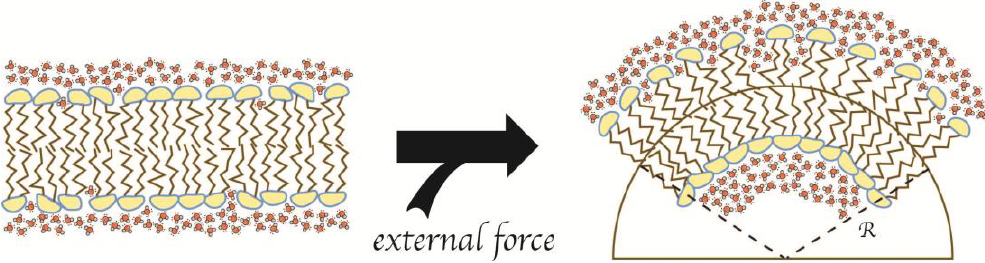
Figure 6. Bending of the lipid bilayer by external forces. The membrane is shown as a lipid bilayer surrounded by water molecules ( red / white ). External forces, such as scaffolds, molecular motors, or AIMs, provide the energy to bend the flat membrane ( left ) into a curved morphology ( right ). The outer leaflet of the membrane now increases the interface between the water molecules and the hydrophobic interior of the membrane, while the lipids of the inner leaflet are compressed.